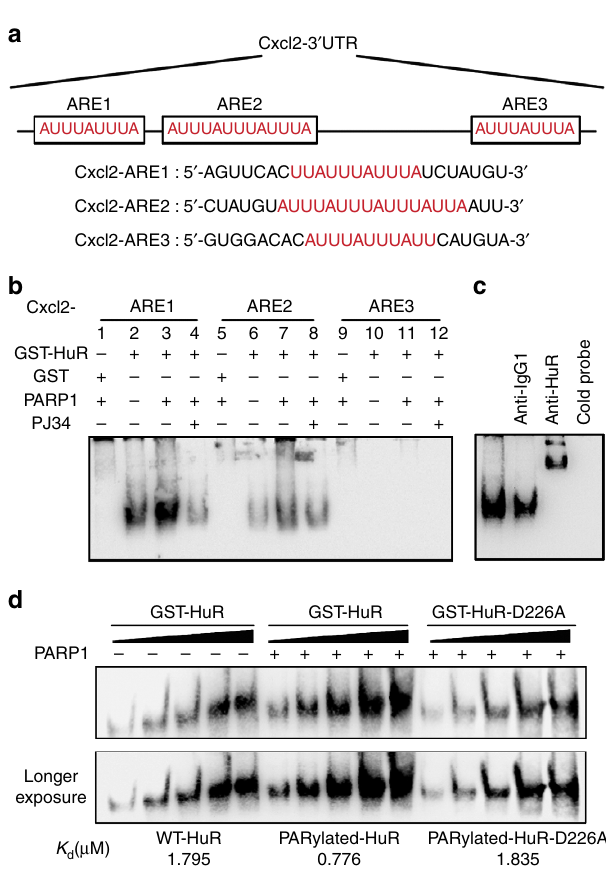
Figure 7 | PARP1 increases the binding of HuR with AREs in Cxcl2 mRNA’s 3 0 -UTR. ( a ) Illustration of three AREs in Cxcl2 mRNA’s 3 0 -UTR. ( b ) PARP1 activation promotes the association of HuR with ARE1 and ARE2 in Cxcl2 mRNA’s 3 0 -UTR. In lanes 1, 5 and 9, GST incubated with PARP1 was applied as a control; GST-HuR alone (lanes 2, 6 and 10), and GST-HuR incubated with PARP1 in absence (lanes 3, 7 and 11) or presence (lanes 4, 8 and 12) of PJ34 were subjected to a gel retardation assay. ( c ) Antibody supershift analysis and cold probe competition assay on ARE1 probe. ( d ) Incubation with PARP1 enhances the interaction of WT HuR but not D226A HuR with Cxcl2 -ARE1-containing RNA. Varying concentrations of GST-HuR or GST-HuR-D226A (100, 200, 400, 800 and 1,600nM; calculated by utilizing bovine serum albumin (BSA) concentration standard formula) were incubated with PARP1, or not, and a gel retardation assay was performed as described above. Quantifications of bound and unbound signal allowed dissociation constants ( K d ) to be